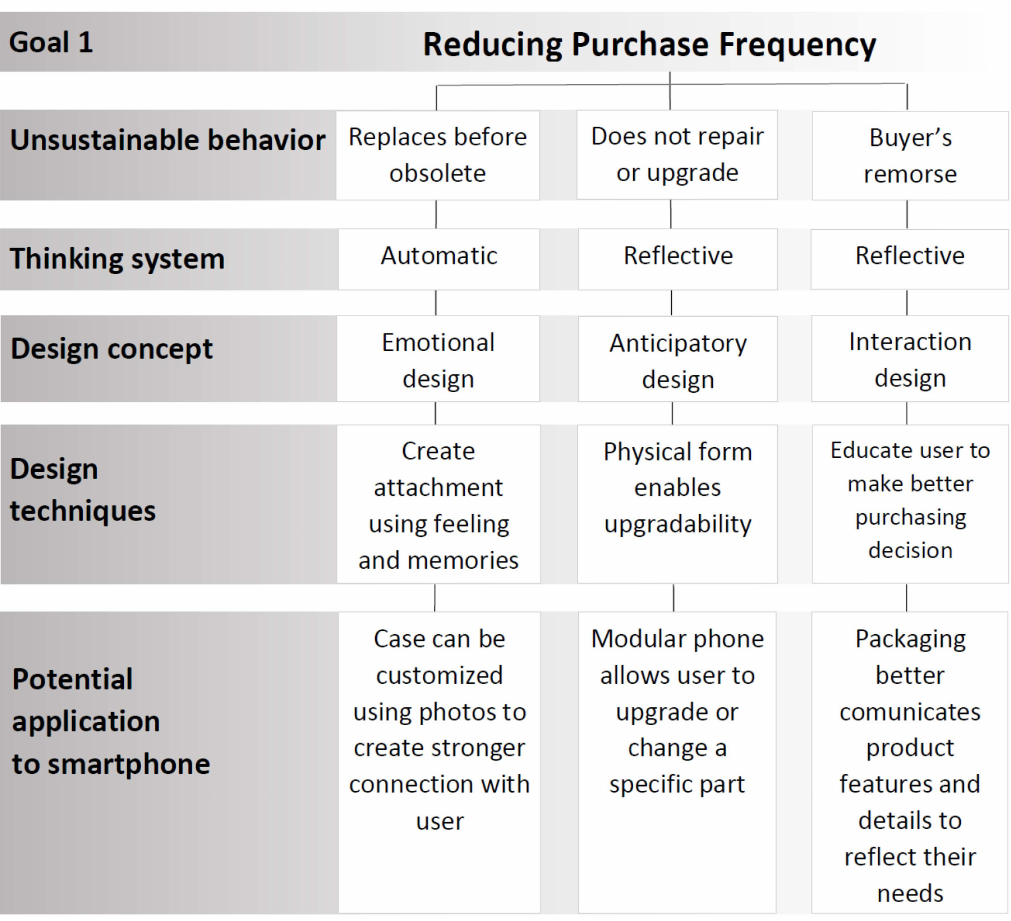
Figure 3. SBD framework applied to meet Goal 1, “Reducing Purchase Frequency”: examples of how images, modular design, or packaging extend product